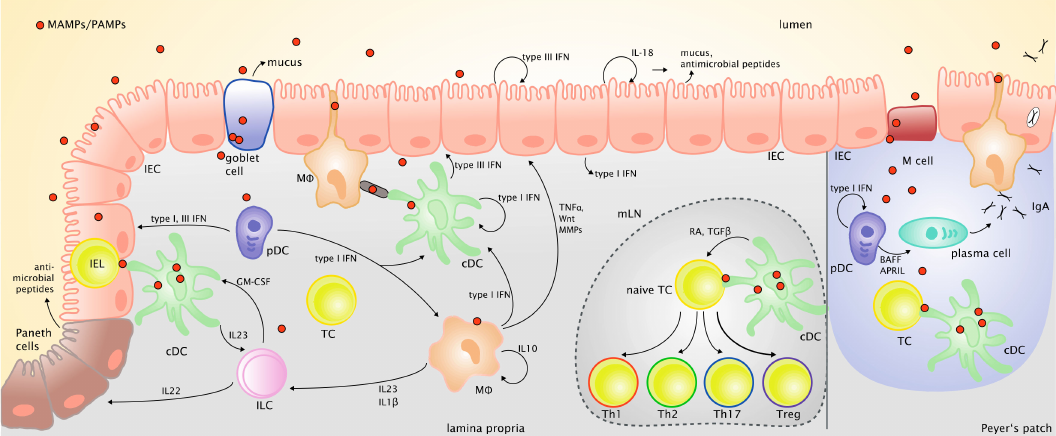
Figure 2. Antigen uptake routes and multicellular responses in the intestine. MAMPs/PAMPs are taken up from the intestinal lumen into the lamina propria via goblet cells or macrophages, which forward the antigens to cDCs, which then present the antigens to IELs or naïve TC in the mLN. There, they induce TC differentiation by expression of costimulatory molecules and cytokine secretion. M φ do not migrate to the mLN but secrete cytokines and factors, supporting tissue remodeling and repair. Autocrine IL-10 signaling keeps them in a hyporesponsive state, preventing excessive proinflammatory cytokine release. Type I IFN secreted by pDCs, cDCs and IECs acts on M φ , influencing their activation status, and on IEC and cDC themselves, inducing ISG expression (IECs) and cytokine secretion (cDCs). Autocrine type III IFN and IL-18 signaling is beneficial for IECs, as well as IL-22, secreted by ILCs, which in turn are influenced by cDC or macrophage derived IL-23 and IL-1 β . In addition to IL-22, ILCs secrete GM-CSF that influences cDC phenotype and survival. In the Peyer’s patches of the small intestine, M cells and M φ provide antigens, which are presented to TC by cDCs. In the FAE of the Peyer’s patches pDC-derived BAFF and APRIL promotes IgA production by plasma cells. Used abbreviations in alphabetical